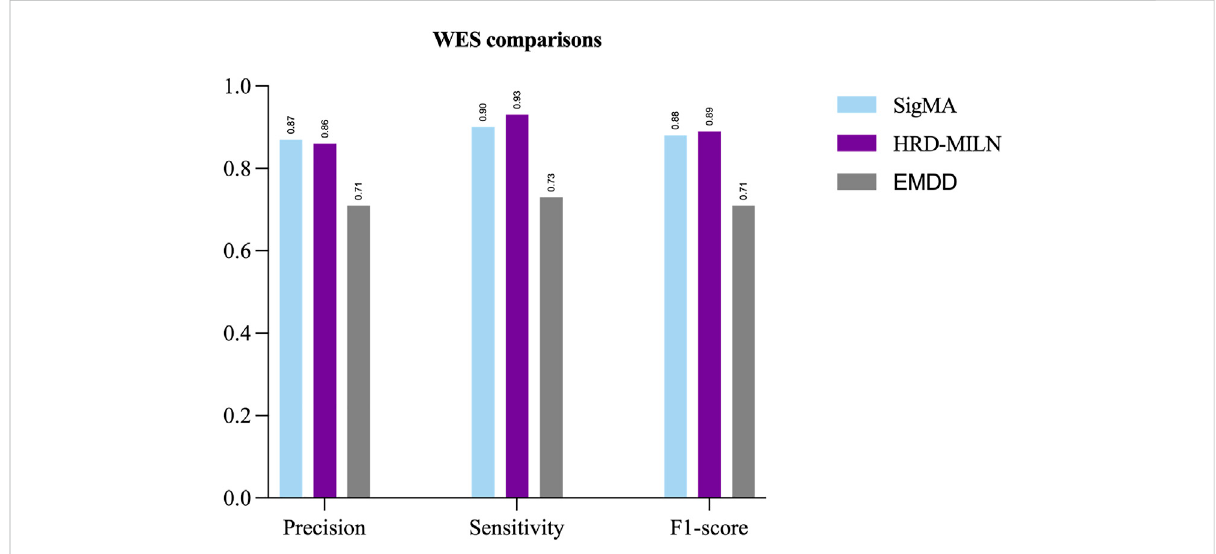
FIGURE 5 The performances of SigMA, EMDD, and HRD-MILN in whole-exome sequencing samples. HRD-MILN had the highest scores (precision 0.86, sensitivity 0.93, F1-score 0.89) than SigMA and EMDD on each Evaluation